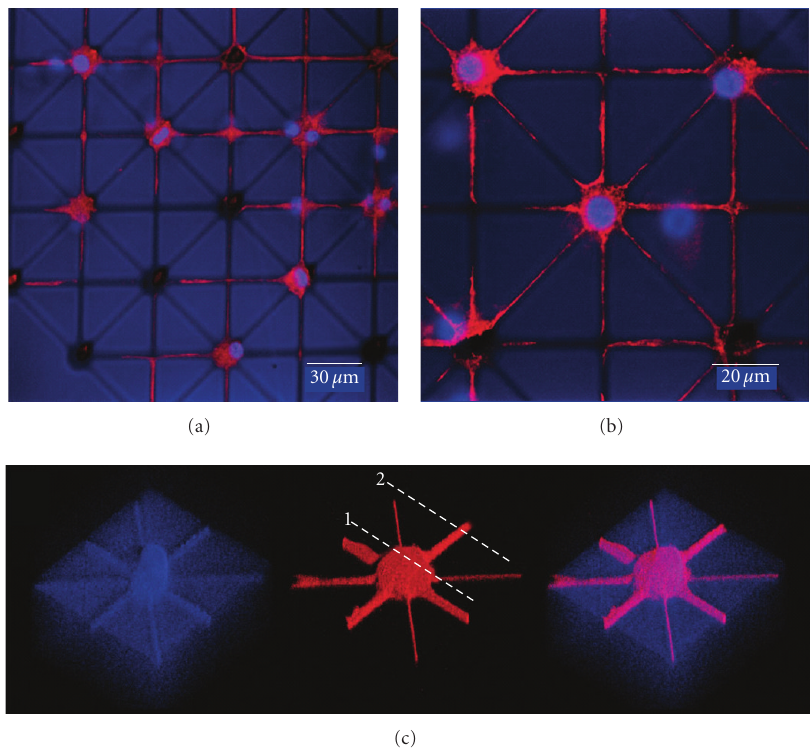
Figure 10: Confocal microscopy images of PC12 cells grown on electron-beam-lithography-patterned network of microwells (10mm diameter) connected by microchannels (1mm width). The cells were treated with NGF (for 48 hours) and immunostained with DAPI (cell nuclei, blue), FITC antivinculin antibody (focal contacts, red), and TRITC phalloidin (actin filaments, red)